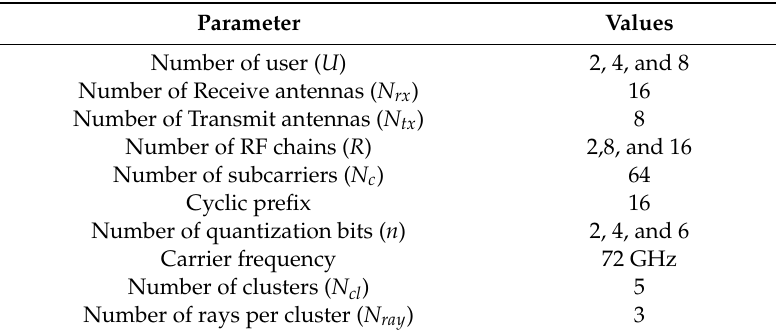
Table 1. Main simulation